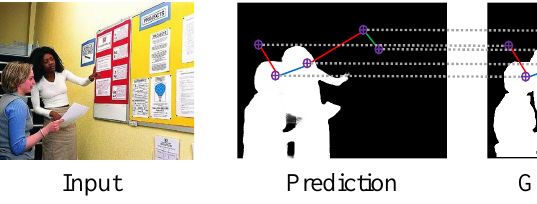
Figure 3. Illustration of our proposed label-guided ranking